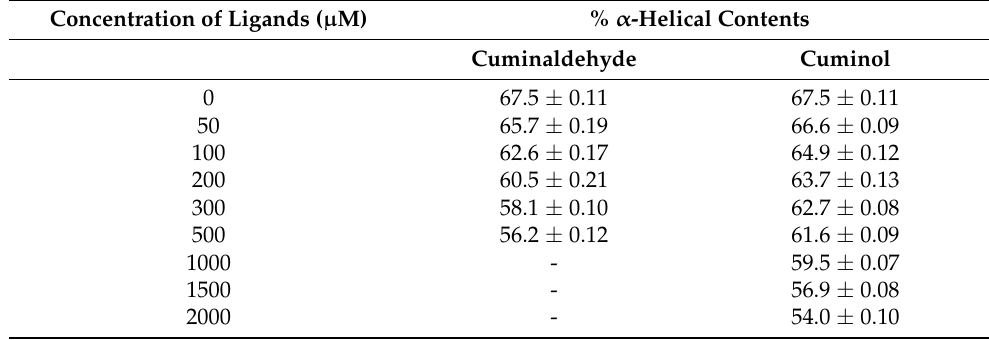
Table 6. The % α -helical contents of HSA (3 µ M) in presence of various concentrations of cuminalde- hyde/cuminol at 25 ◦